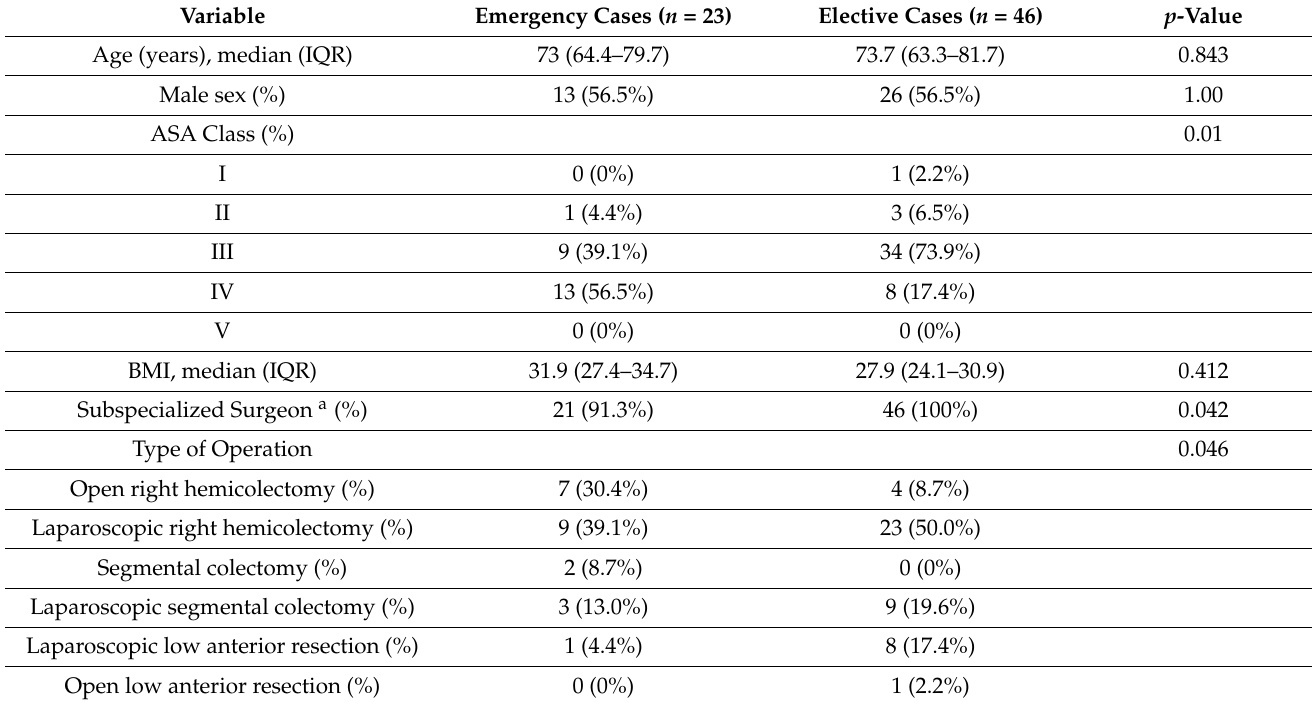
Table 1. Baseline